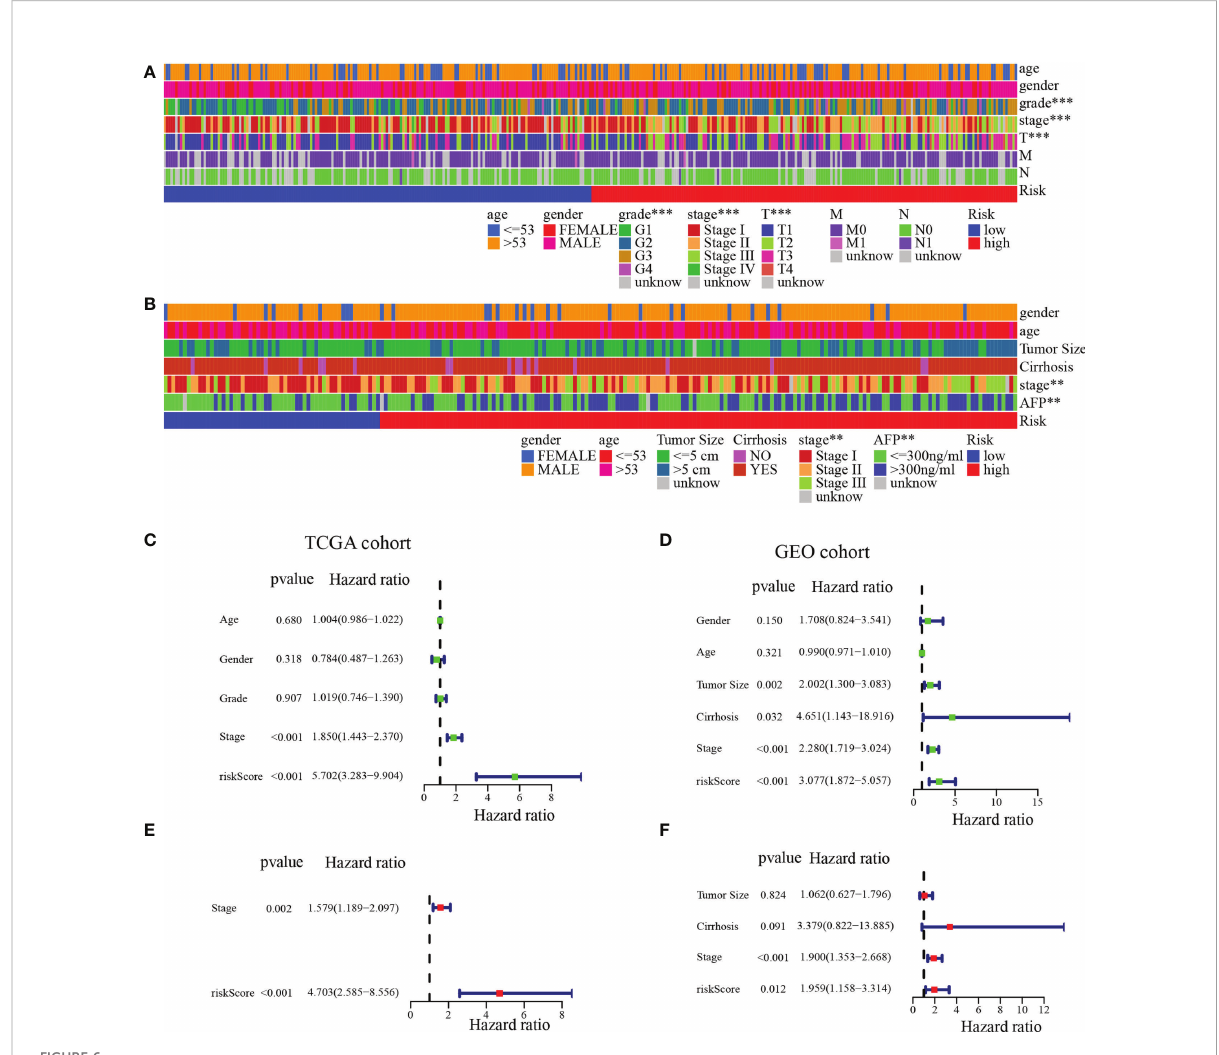
FIGURE 6 Independent prognostic analysis of risk score. (A) Clinical relevance of the high-risk and low-risk groups in the TCGA cohort. (B) Clinical relevance of the high-risk and low-risk groups in the GEO cohort. Univariate (C) and multivariate (E) Cox regression analyses of risk score and clinicopathological parameters in the TCGA cohort. Univariate (D) and multivariate (F) Cox regression analyses of risk score and clinicopathological parameters in the GEO cohort. ** p < 0.01; *** p <